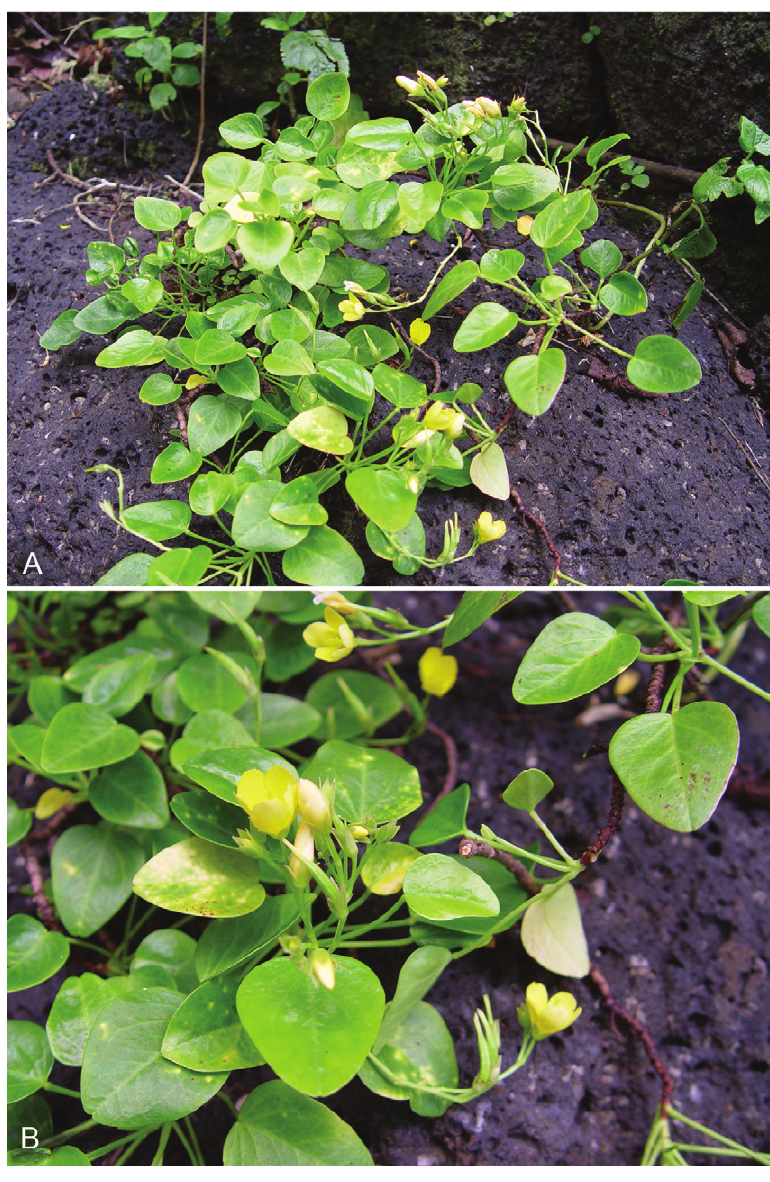
Figure 2. Field images of Oxalis simplicifolia A habit B stems with flowers and fruits (Perlman & Wood